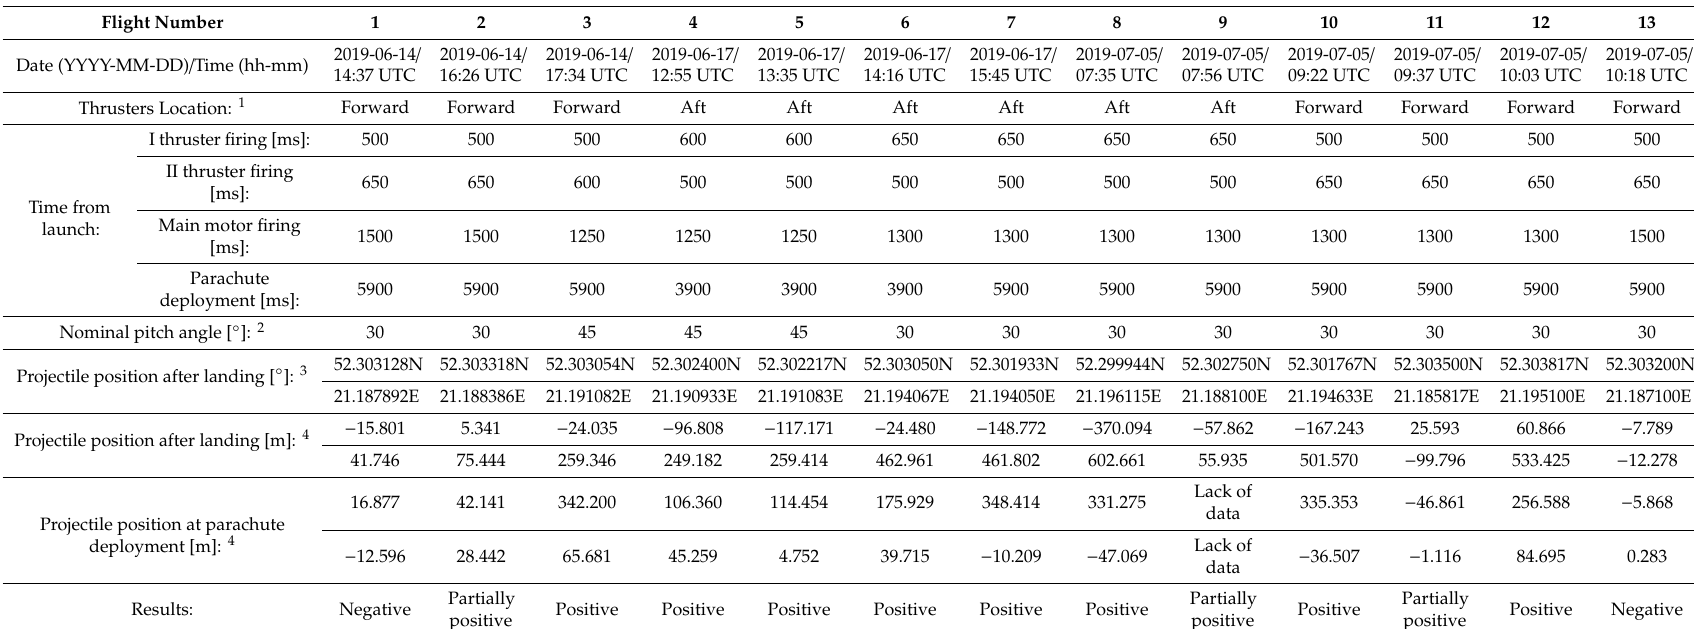
Table 5. Summary of the flight tests